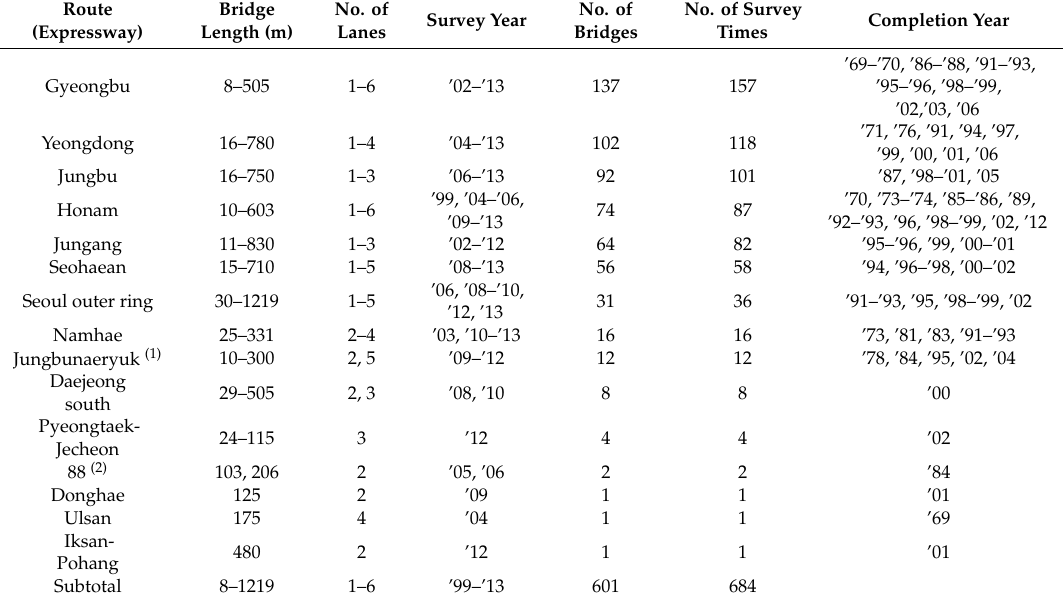
Table 1. Details of survey bridges in this